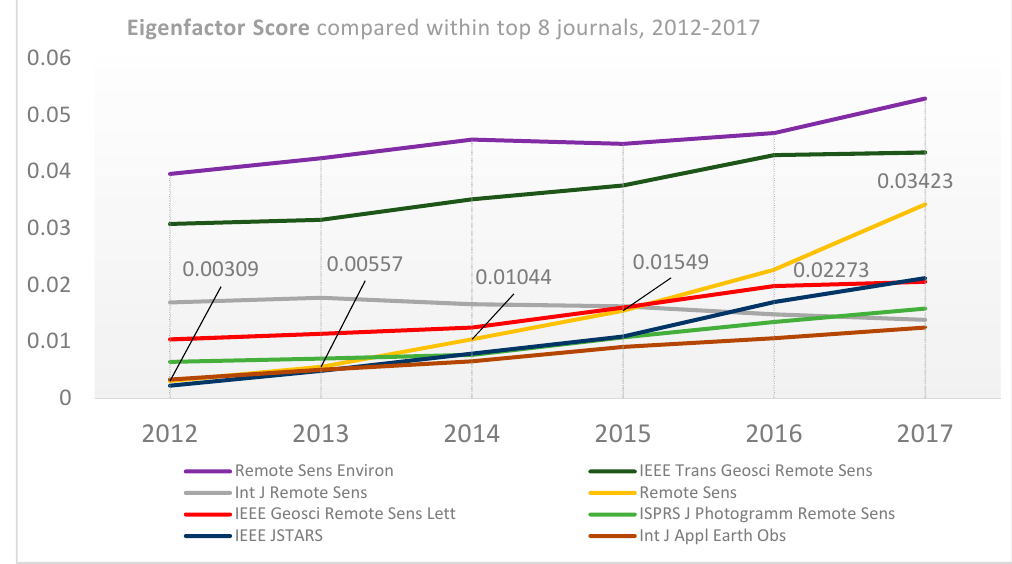
Fig ure 3 Figure 3. Eigenfactor score of RS OAJ during 2017 was 0.03423, which is third amongst all remote sensing journals.